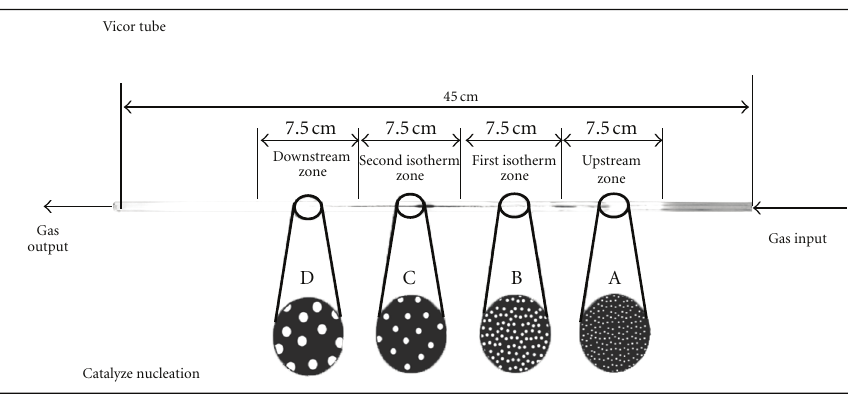
Figure 2: Vicor tube image, with measurements and identification of zones.